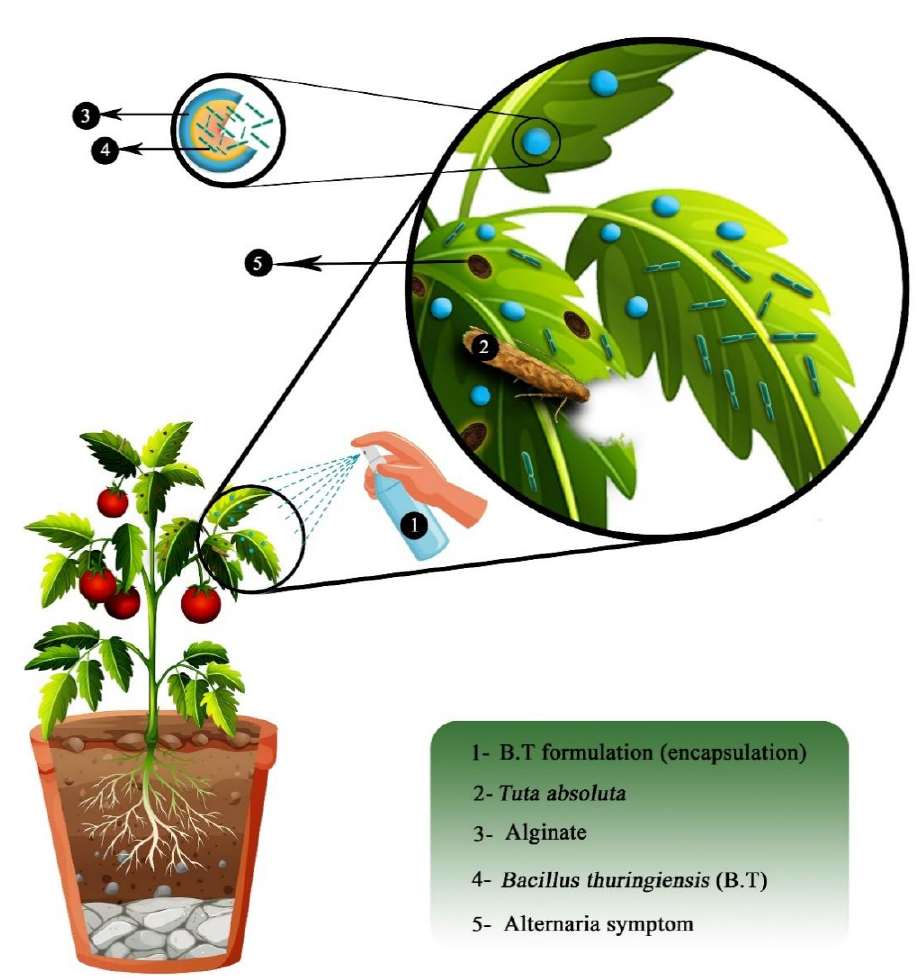
Figure 7. The effect of biocontrol bacteria microcapsules on biocontrol of pests and diseases.